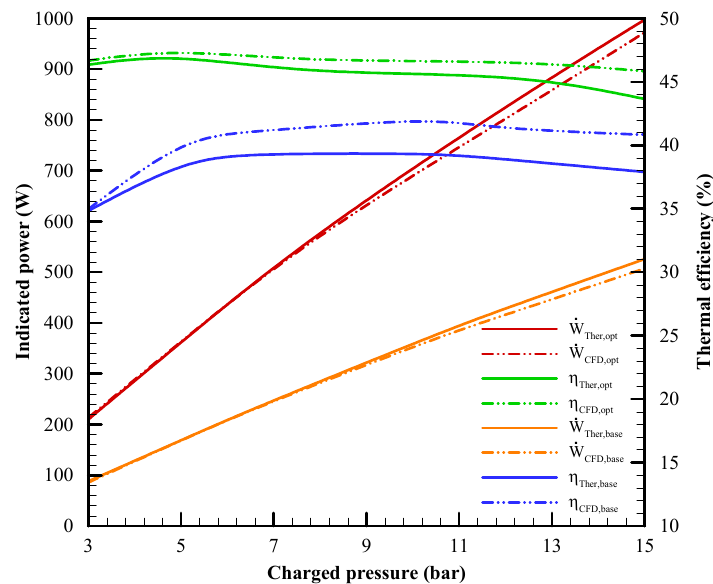
Figure 6. Variation of the optimal engine performance with heating temperature. Figure 7 shows the effect of charged pressure on the optimal engine performance over the range from 3 to 15 bar. The thermal efficiency and the indicated power before Figure 8 points out the effect of the rotation speed on the optimal engine performance optimization are well predicted by the modified thermodynamic model with values of over the range from 900 to 2100 rpm. Before optimization, the CFD model and the modified unknown coefficients in Table 3 and the CFD model, presented in Ref. [18]. The indicated thermodynamic model in the VSCGM optimizer show a good agreement. Their respective power varies linearly from 88.2 W to 526.0 W and the thermal efficiency varies linearly maximum differences in the indicated power and the thermal efficiency are 2.4 W at from 34.8 to 37.9% with a charged pressure from 3 to 15 bar. The thermal efficiency tends 1350 rpm and 1.1% at 2100 rpm. After optimization, the raise in rotation speed over this to decrease when the charged pressure is over 9 bar. After optimization, the optimal indi- range leads to an improvement in both the optimal indicated power and the optimal cated power linearly surges from 210.2 to 997.5 W and the optimal thermal efficiency de- thermal efficiency. The optimal thermal efficiency goes down from 51.1 to 38.7% and the creases slightly from 46.4 to 43.7% as the charged pressure varies from 3 to 15 bar. The optimal indicated power rises from 146.7 to 226.6 W as the rotation speed increases from double-check from the CFD model shows that the maximum difference in the optimal 900 to 2100 rpm. The comparison between the CFD model and the VSCGM optimizer thermal efficiency is 2.2% and that in the optimal indicated power is 25.2 W at a 15-bar indicates that the respective maximum differences in the optimal thermal efficiency and charged pressure. the optimal indicated power are 1.7% and 15.9 W at 2100 rpm.